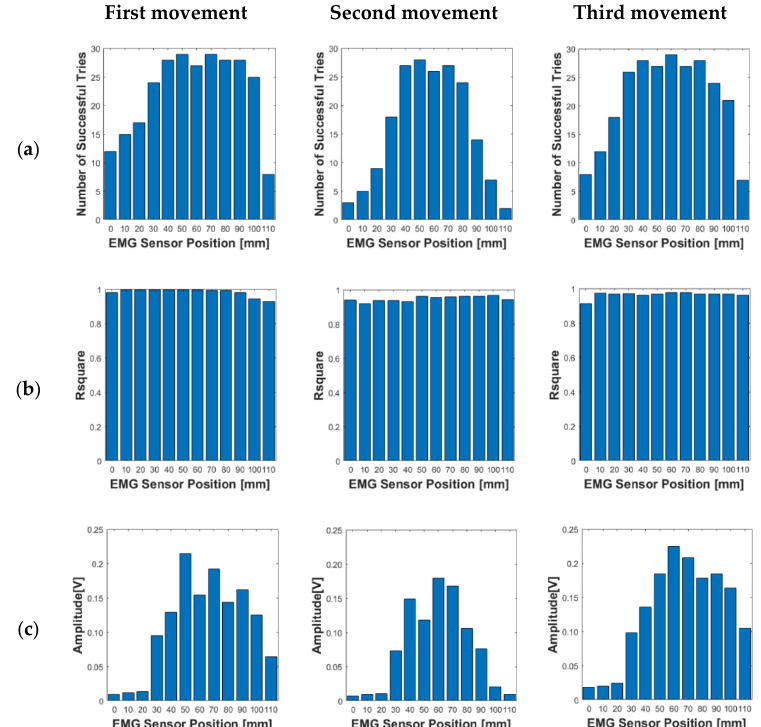
Figure 7. Results of the achievement of the best positioning of the sensor probe. For each of the three finger movements and in relation to the sensor probe position: line ( a ) average number of successful trials; line ( b ) average R-square standard values; line ( c ) average amplitudes.